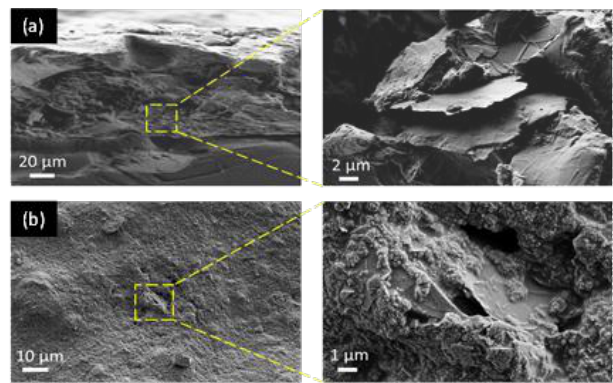
Figure 9. FE-SEM images of the cross section ( a ) and surface ( b ) of the graphene-based paint loaded at 4.5 wt.% of